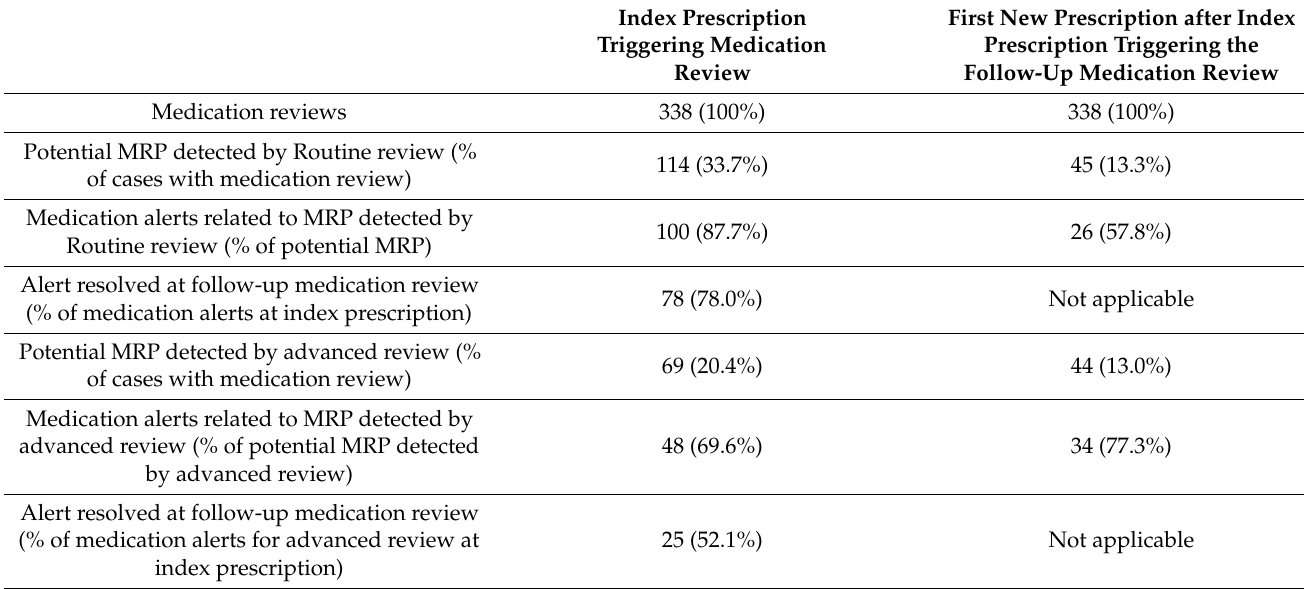
Table 1. Prospective assessment of routine and advanced review.